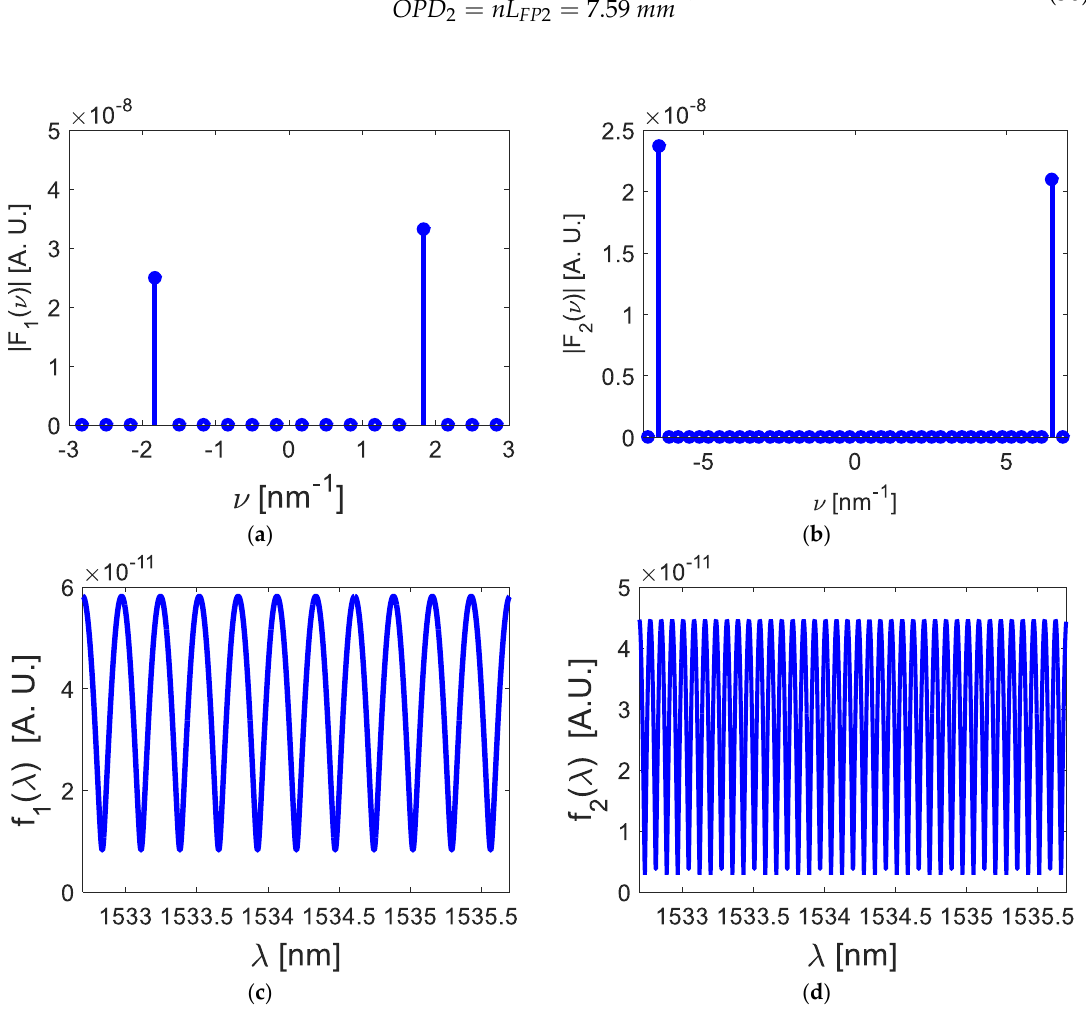
Figure 7. Cosine function representation: ( a ) 𝐹 1 (𝜈) expressed in the frequency domain; ( b ) 𝐹 2 (𝜈) expressed in the frequency domain; ( c ) 𝑓 1 (𝜆) expressed in the wavelength domain; ( d ) 𝑓 2 (𝜆) expressed in the wavelength domain.